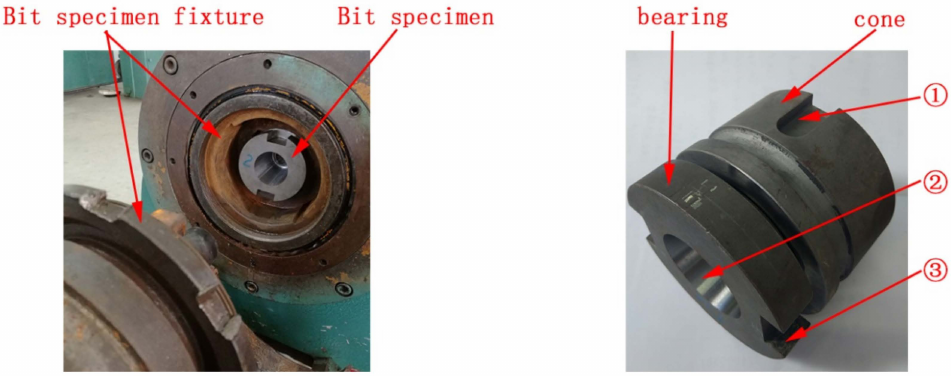
Figure 7. Drilling bit and